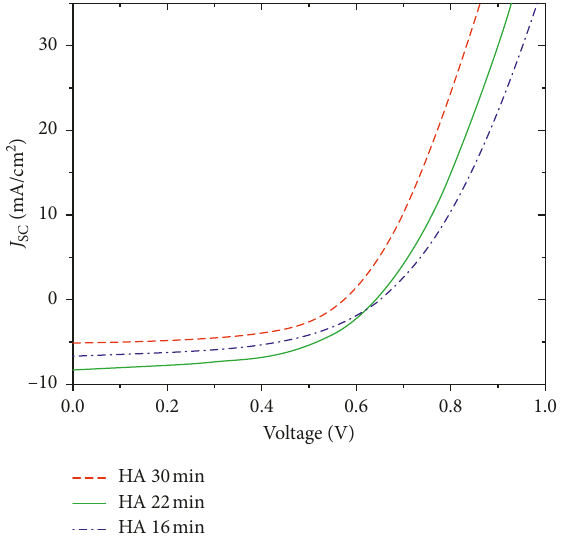
Figure 2: J-V curves of solar cell devices based on HA washing treatment